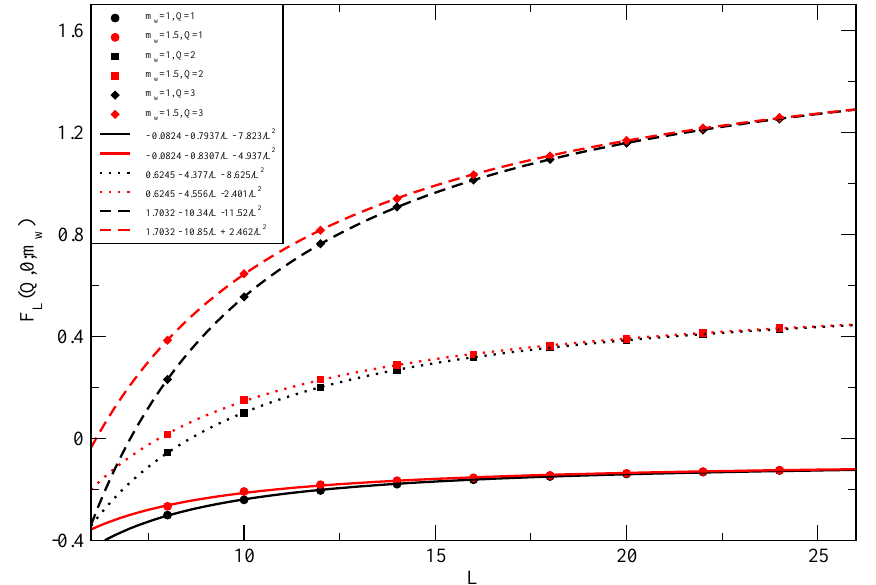
Figure 5. The plot demonstrates the existence of the continuum limit of the overlap fermion action in constant flux background at zero h 3 . The continuum extrapolations ( L expansion in lattice spacing 1/ L . The consistency in the extrapolated values using different regulator parameter m w is